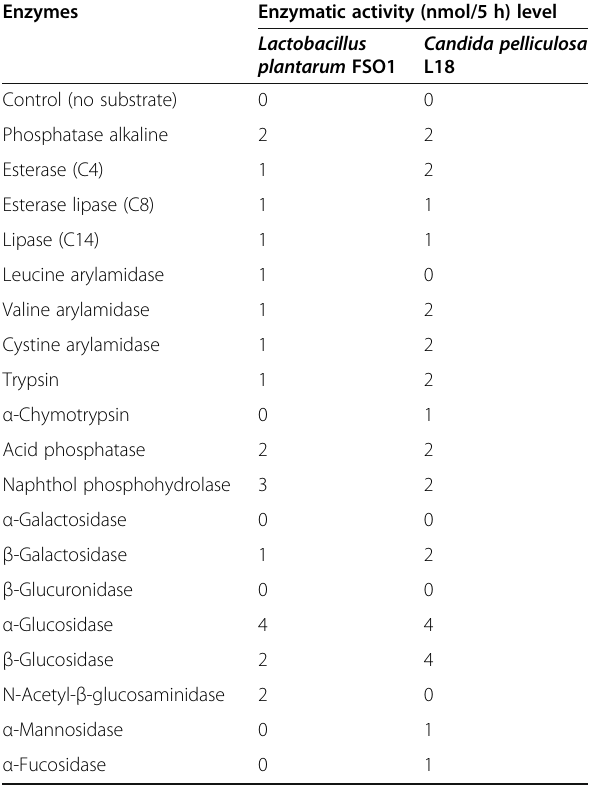
Table 1 Enzymatic activity of oleuropeinolytic strains obtained by API-Zym